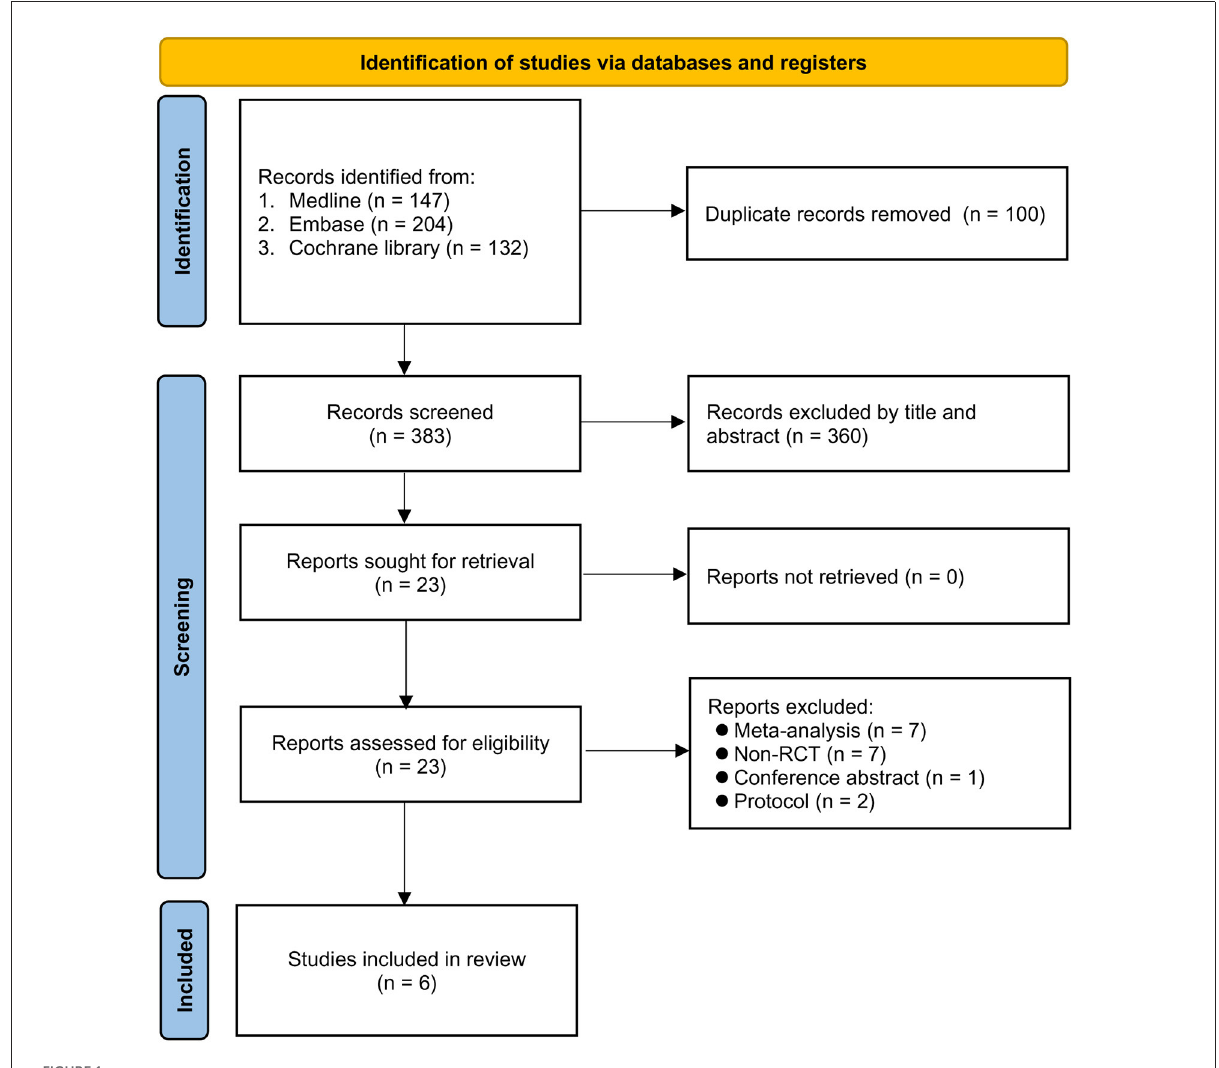
FIGURE1 PRISMA flow diagram of study selection for the current